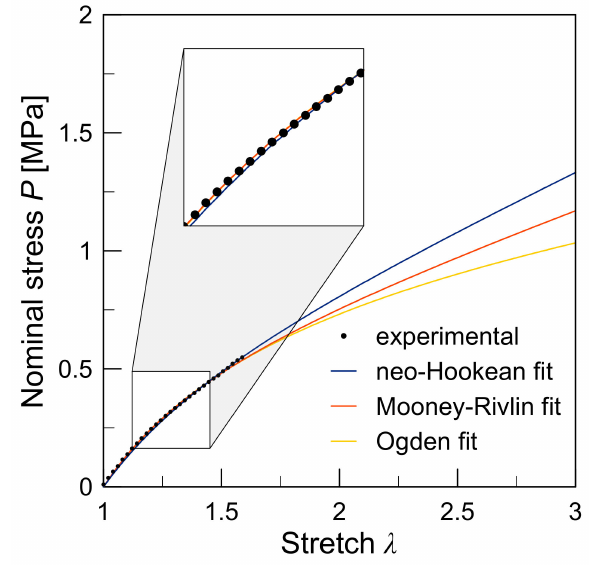
Figure 1. Typical curve obtained from tensile testing of a silicone rubber (experimental and fitted data). The enlarged inlet shows the region λ = 1.2–1.4, with excellent agreement between the different